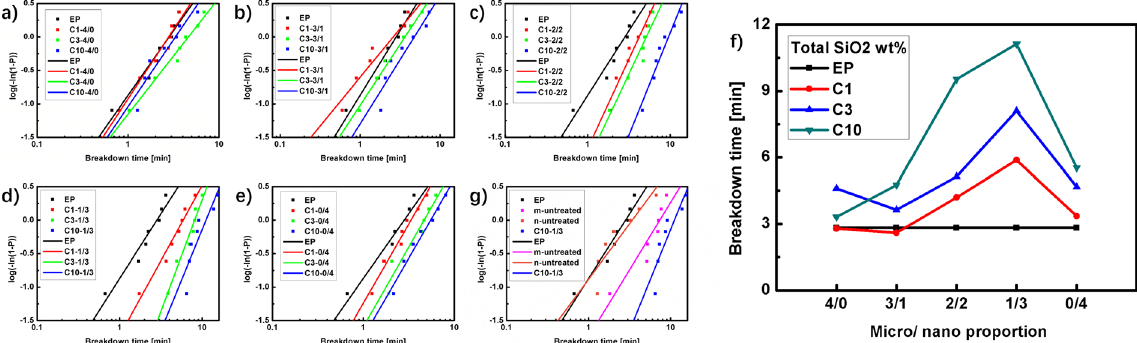
Figure 2. ( a–e ) Weibull distribution of the breakdown time of the epoxy/SiO2 composites with different total SiO2 concentrations and different micro/nano proportions. ( f ) The scale parameter α that indicates the breakdown time at the cumulative probability of 63.2%. ( g ) Weibull distribution of the breakdown time of the epoxy/SiO2 composites with a total SiO2 concentration of 10 wt% and a micro/nano proportion of